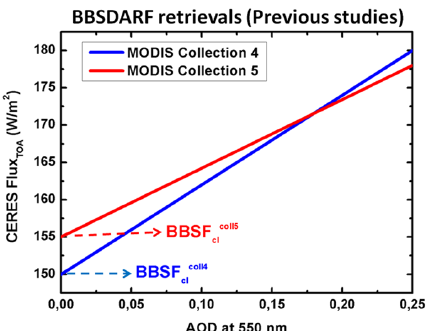
Figure 5. Schematic illustration of the differences in the linear fits of CERES flux at the top of the atmosphere (TOA) and MODIS collection 4 and collection 5 aerosol optical depth (AOD) at 550nm. No real data were used in this